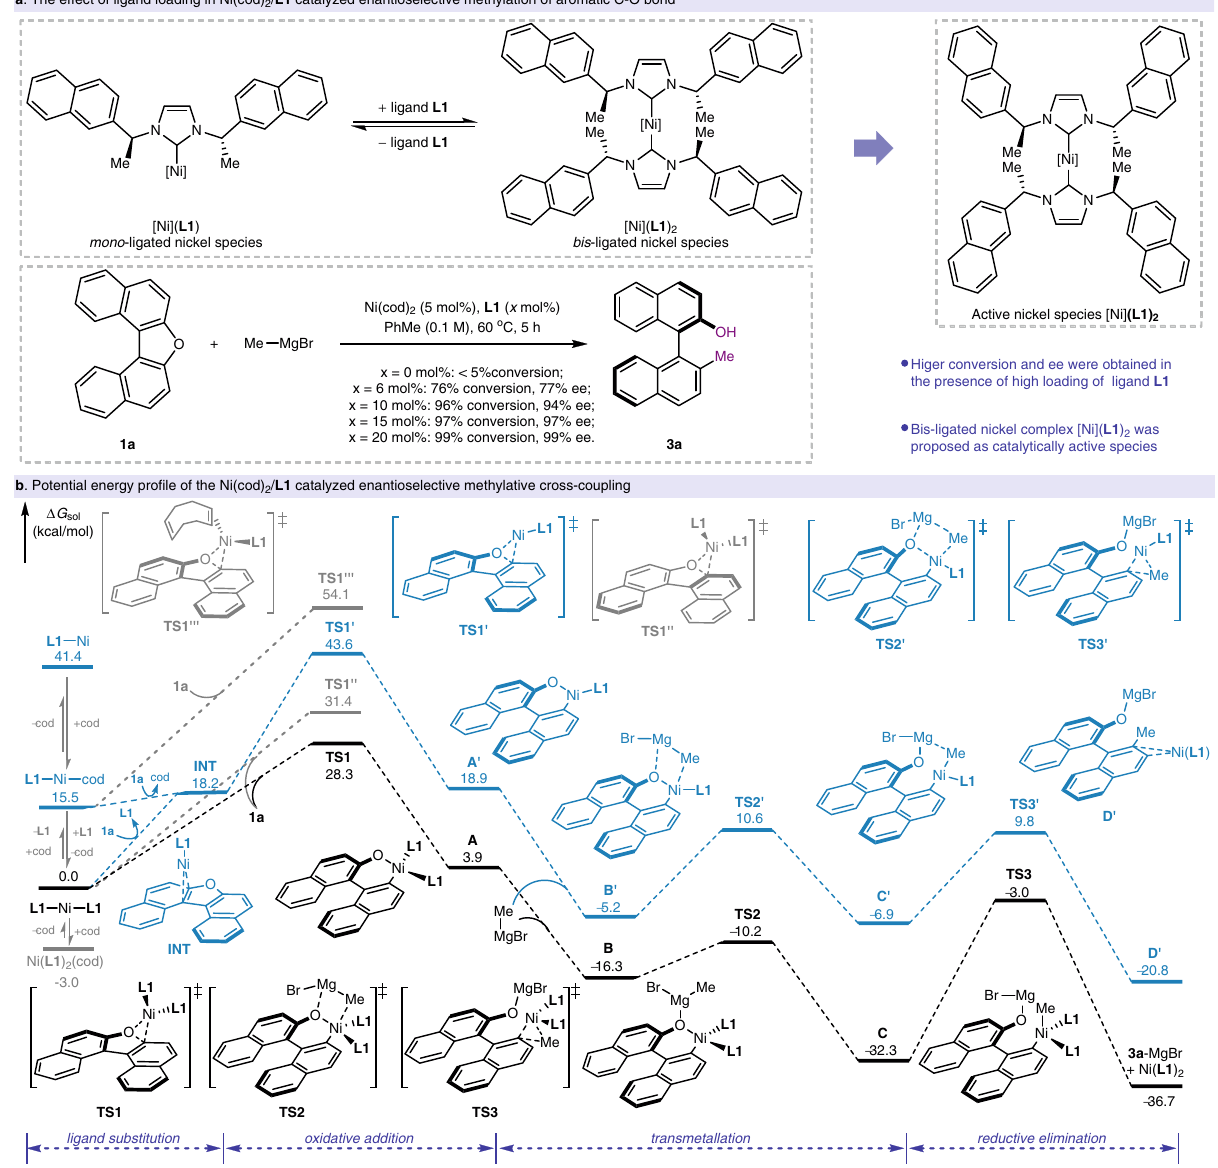
Fig. 3 Mechanistic investigation. a The effect of ligand loading in Ni(cod) 2 / L1 catalyzed enantioselective methylation of aromatic C – O bond; b Potential energy pro fi le (PES) of the Ni(cod) 2 / L1 catalyzed enantioselective methylative cross-coupling. Black: PES of the Ni( L1 ) 2 catalyzed enantioselective methylative cross-coupling; Blue: PES of the Ni( L1 ) catalyzed enantioselective methylative